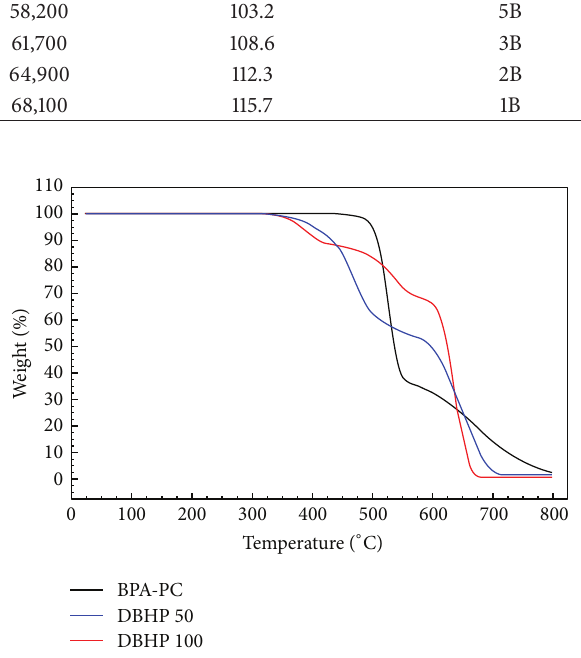
Figure 3: TGA of BPA-PC and